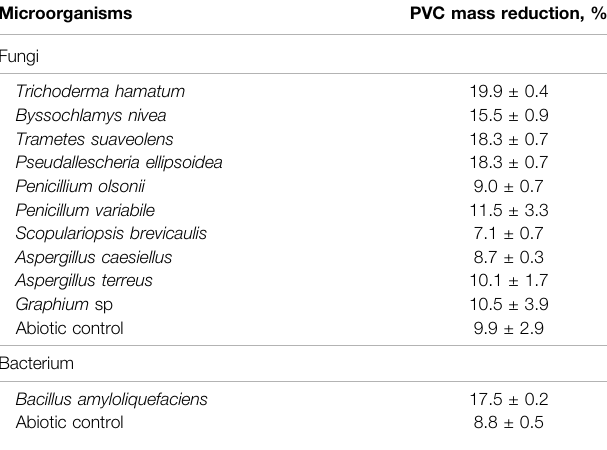
TABLE 2 | Mass-reduction of PVC fi lm by new isolated strains in liquid medium after 60 days at 28 ° C.